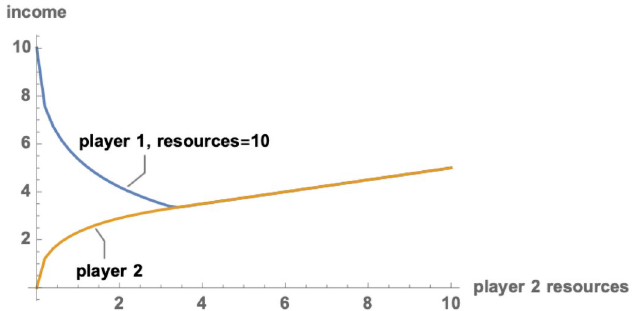
Fig 1. The paradox of power. Incomes (resources-minus-fighting-efforts) in a two person game for player 1, resources = 10 (arbitrary units), and player 2, varying resources.